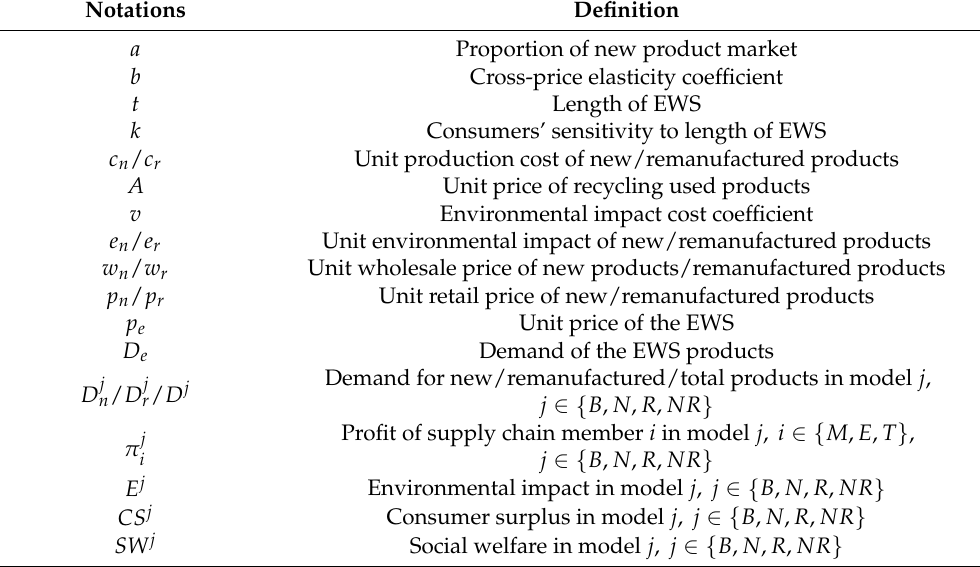
Table 1. Parameters and decision